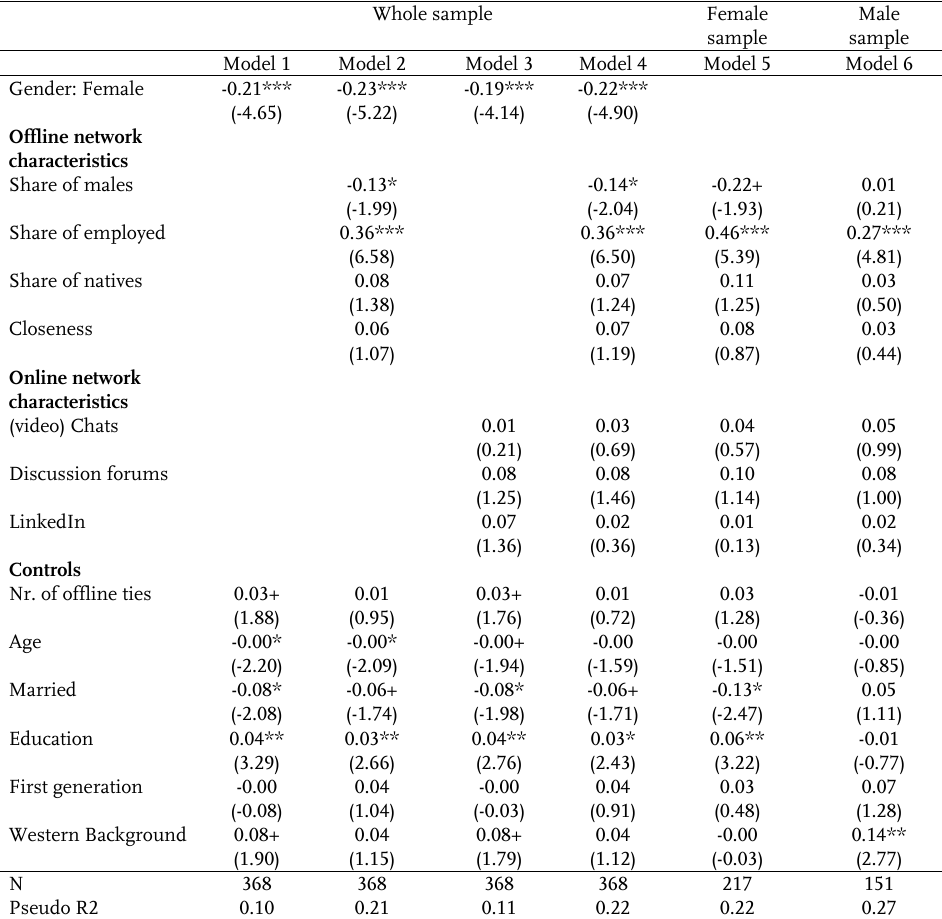
Male sample sample